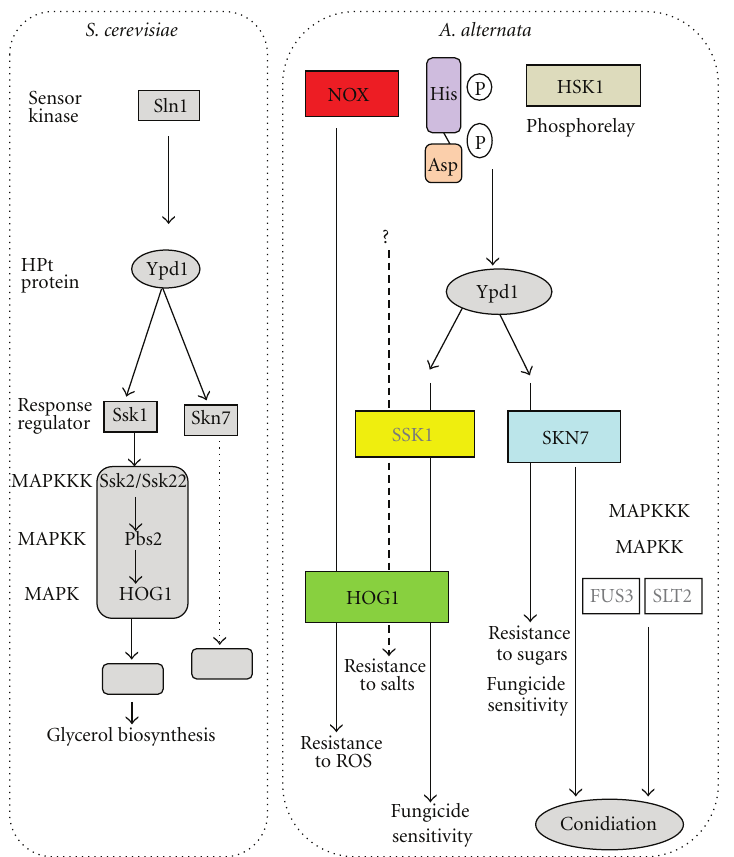
F 3: Schematic illustration and comparison of signaling pathways leading to osmotic stress resistance in the budding yeast, S . cerevisiae , and the pathways leading to ROS resistance, osmotic stress response, fungicide sensitivity, and conidia formation in the tangerine pathotype of A . alternata